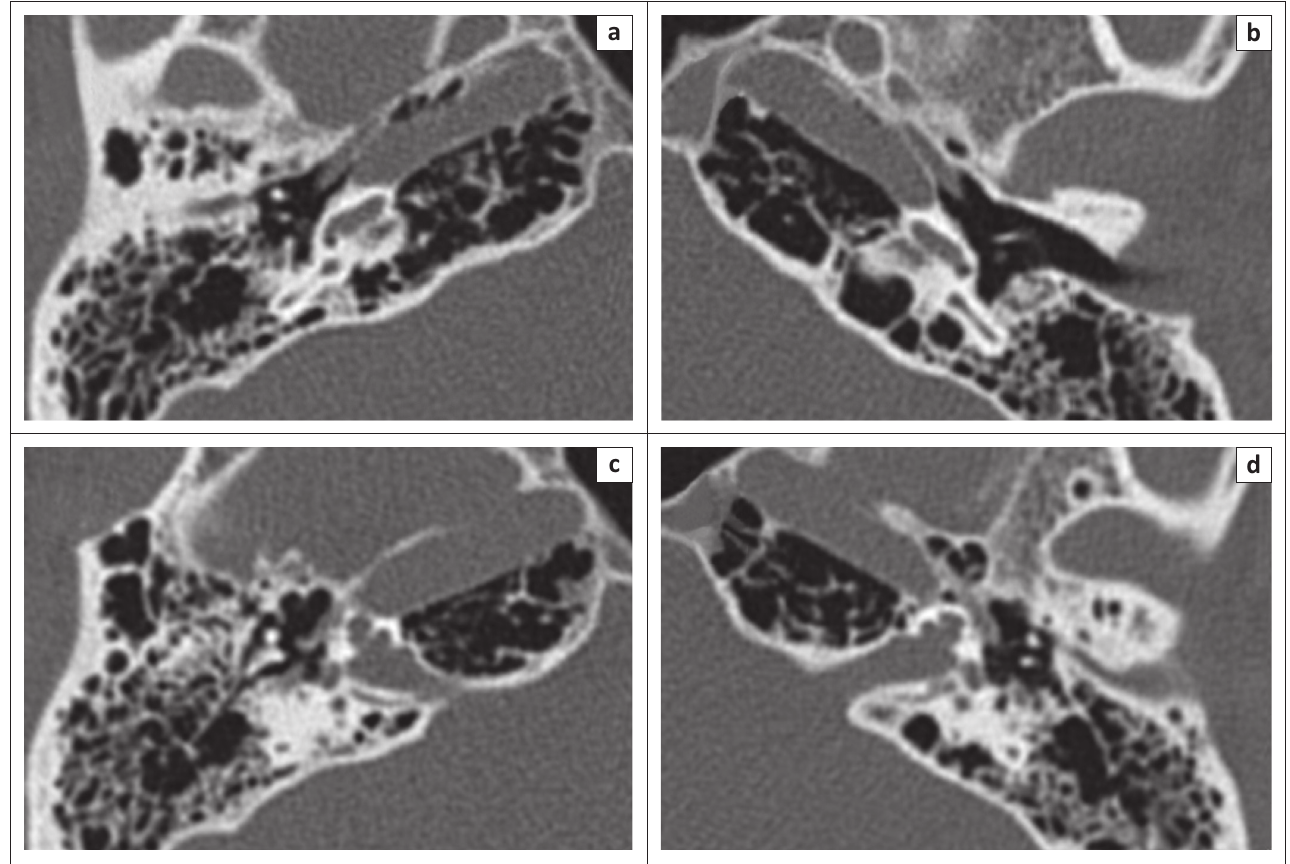
FIGURE 1: Axial images through the right (panel a, c, e and g) and left (panel b, d, f and h) petrous